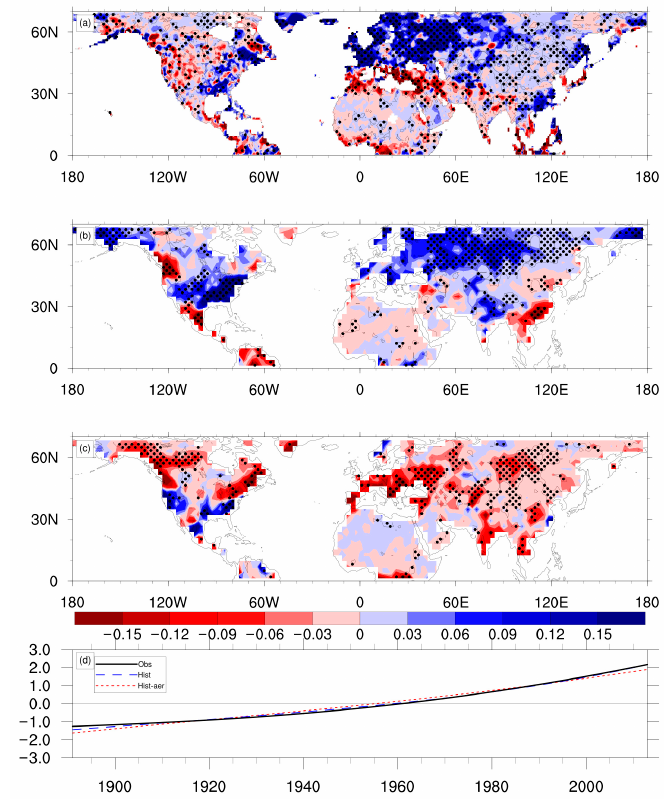
Figure 8. Spatial distributions of the leading EOF of the externally forced wintertime land precipitation in northern hemisphere from ( a ) GPCC, ( b ) the first member of the CanESM5 model ensemble in CMIP6 historical all-forcings simulation, and ( c ) the first member of the CanESM5 model ensemble in CMIP6 historical aerosol forcing experiment. Regions exceeding 95% significance t -test are dotted. Unit: mm / day. ( d ) The normalized first principle component. Note that the externally forced component of all ensemble members of CanESM5 had a similar feature in a single experiment, thus the result of the first member is displayed.